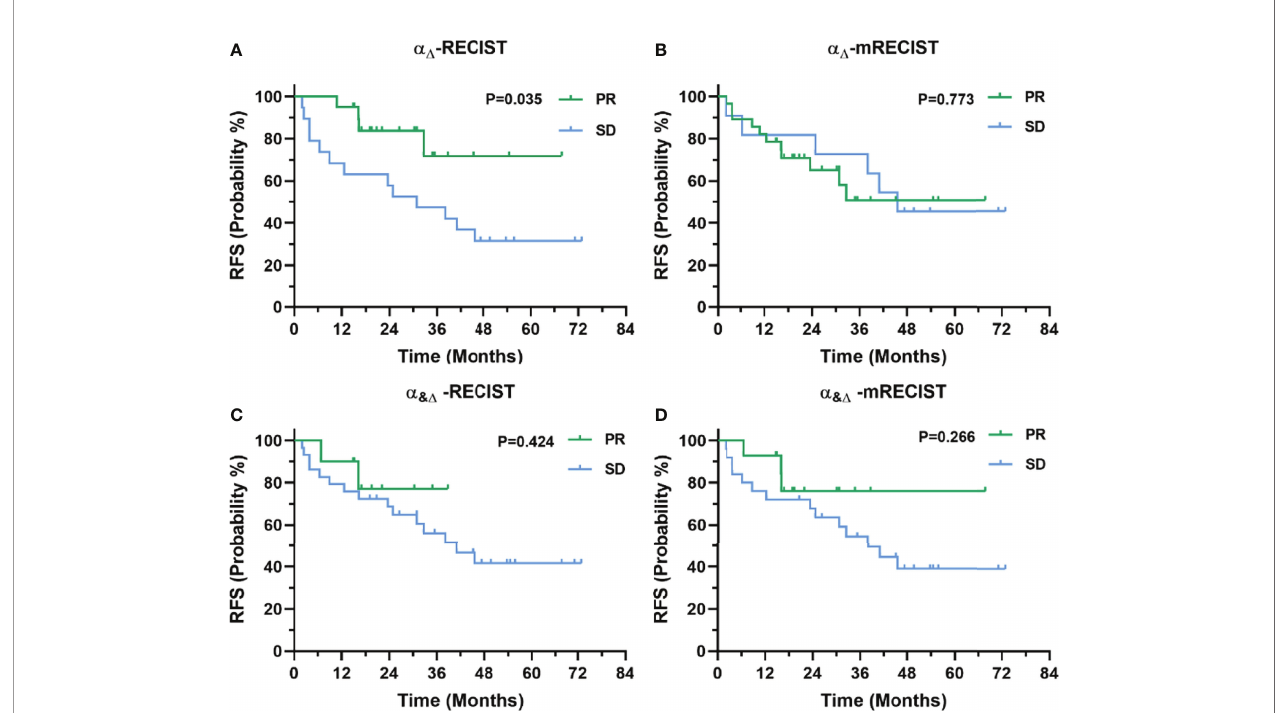
FIGURE 5 | Kaplan-Meier curves for RFS of 39 patients with uHCC undergoing IMRT before hepatectomy as categorized by the a D -RECIST (A) , a D -mRECIST (B) , a & D -RECIST (C) , and a & D -mRECIST (D)